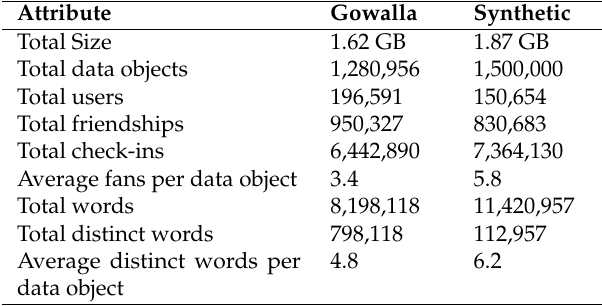
Table 4. Summary of dataset.